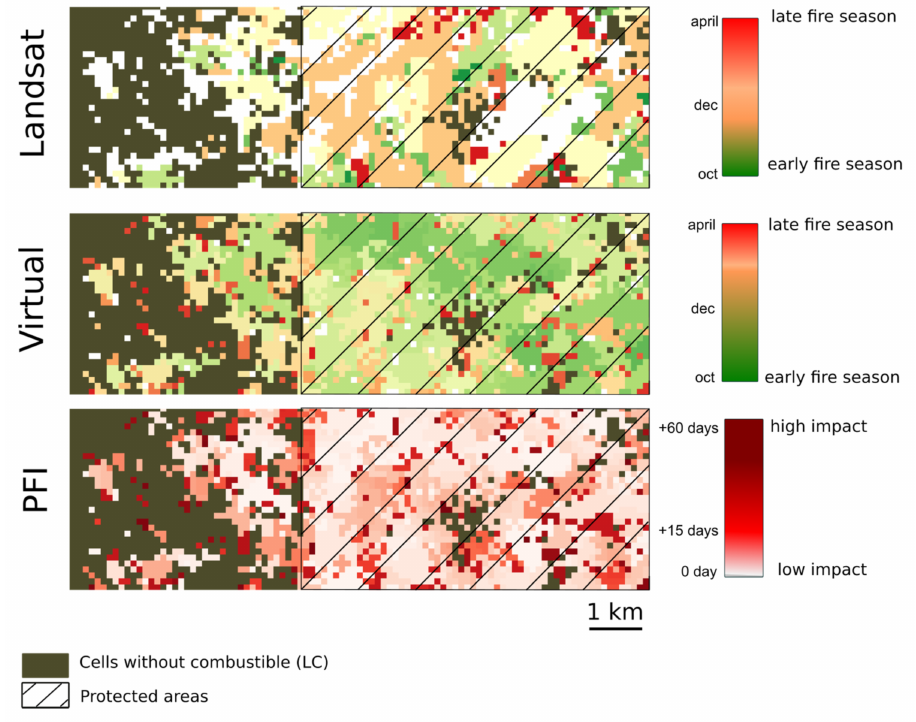
Figure 4. Examples of spatial outputs for the Geo_Fire